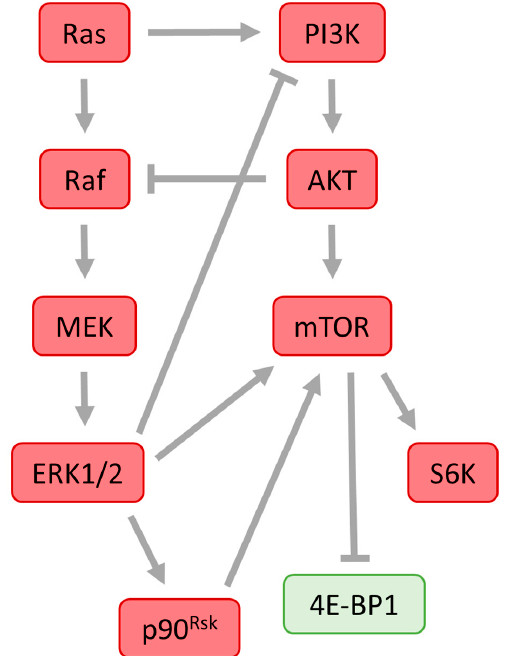
Figure 7. Crosstalk of the Ras/ERK1/2 and PI3K/mTOR pathways. Ras can directly bind and activate PI3K. Protein kinase AKT negatively regulates ERK1/2 activation by phosphorylating inhibitory